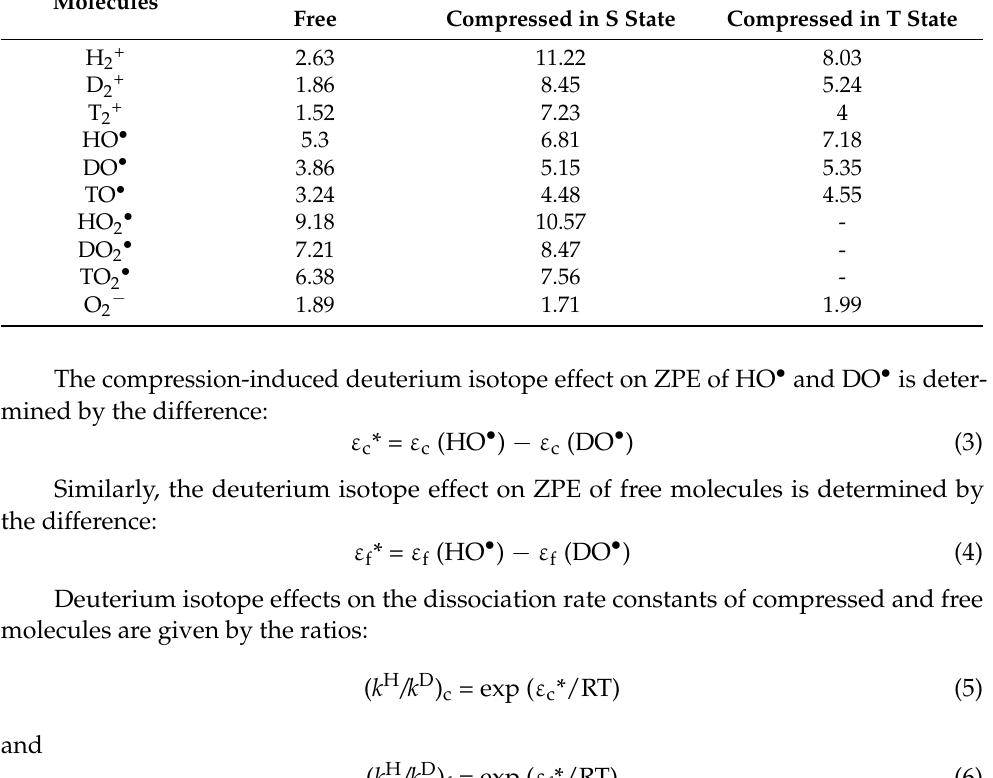
Table 1. ZPE of free and compressed molecules. ZPE, kcal/mol Molecules Free Compressed in S State Compressed in T State H 2+